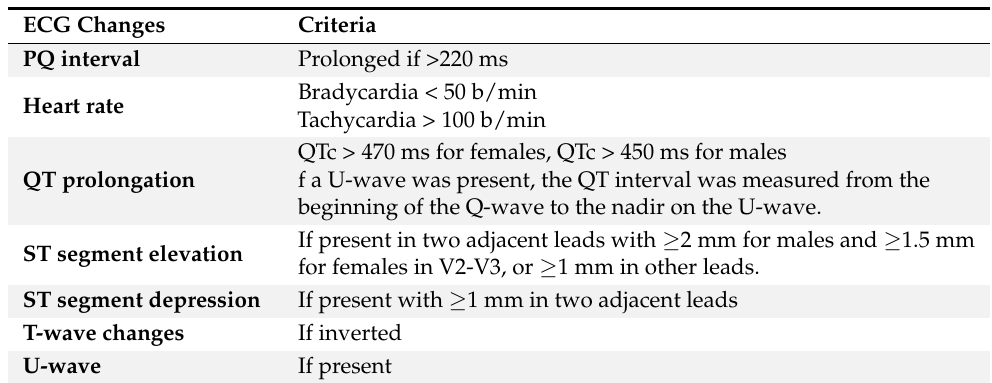
Table 2. Criteria for ECG